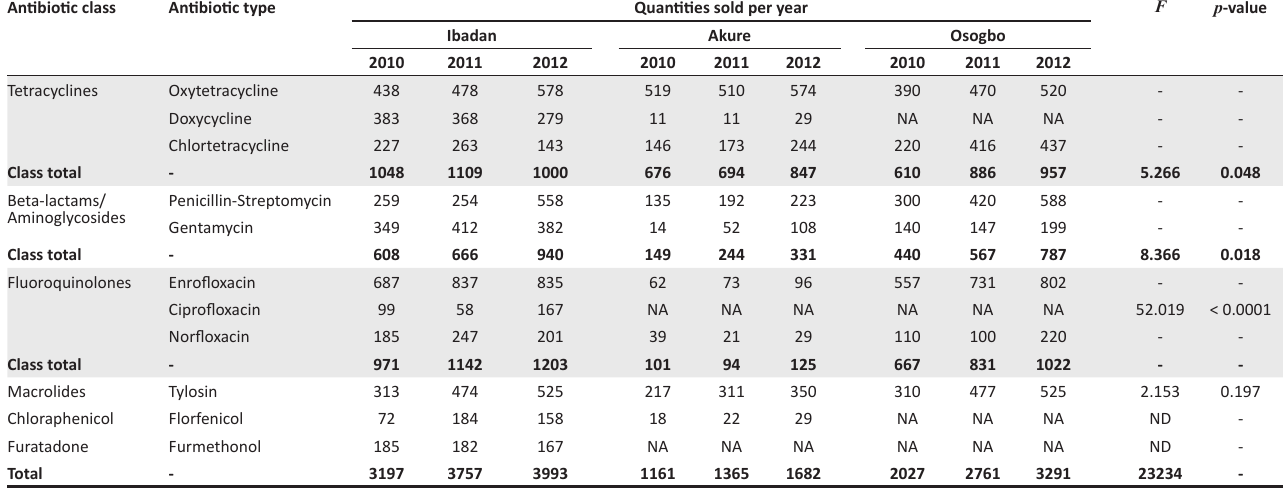
TABLE 1: Distribution of antibiotic usage in livestock production in south-western Nigeria with respect to state (2010–2012). Antibiotic class